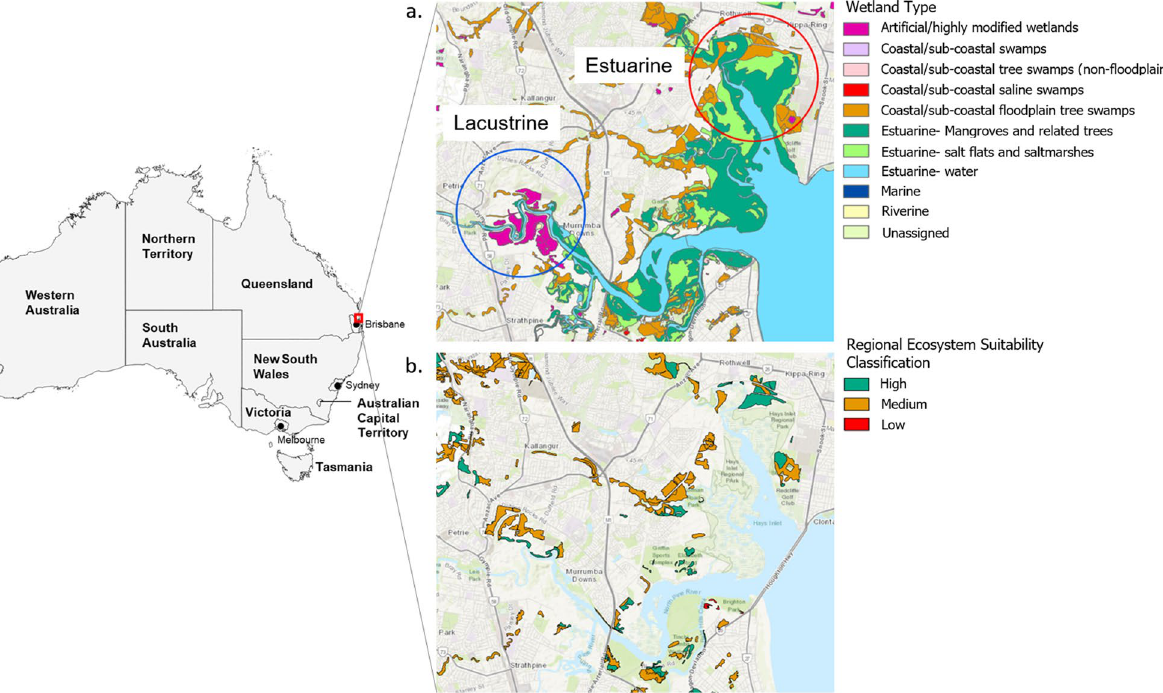
with males (mean = 6.1 ha, 95% CI 4.9–7.3 ha) having greater home ranges than females (mean = 3.0 ha, 95% CI 2.6–3.6 ha). However, no significant differences in home ranges was observed within a sex when consider- ing serostatus (Fig. 2b; F 1,151 = 1.57, p = 0.21). When home ranges were compared between age groups, males and females exhibited a similar trend of increasing home range size with increasing age (Fig. 2c). Significant differences ( F 1,147 = 6.28, p = 0.01) between males and females were only observed within the oldest age group, wherein male home ranges (mean = 10.8 ha, 95% CI 9.3–12.4 ha) were 26% larger than those of similarly aged females (mean = 8.0 ha, 95% CI 7.0–9.0 ha). Differences between the sexes within the older age group may be attributable to the greater movement of older, dominant males during the mating season 27 . The home ranges of individuals that seroconverted during the study were similar (mean = 6.9 ha, 95% CI 3.4–10.4 ha) to those that were seropositive prior to the study or those that remained seronegative, but too few seroconverted to confi- dently compare the three groups.